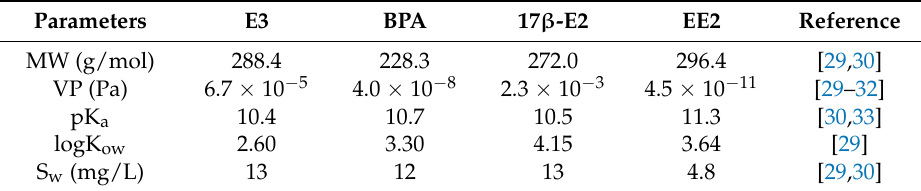
Figure 1. Molecular structures of estriol (E3), 17 β -estradiol (17 β -E2), bisphenol A (BPA), and 17 α -ethinyloestradiol (EE2). Table 1. General physicochemical properties of estrogens used in this study.